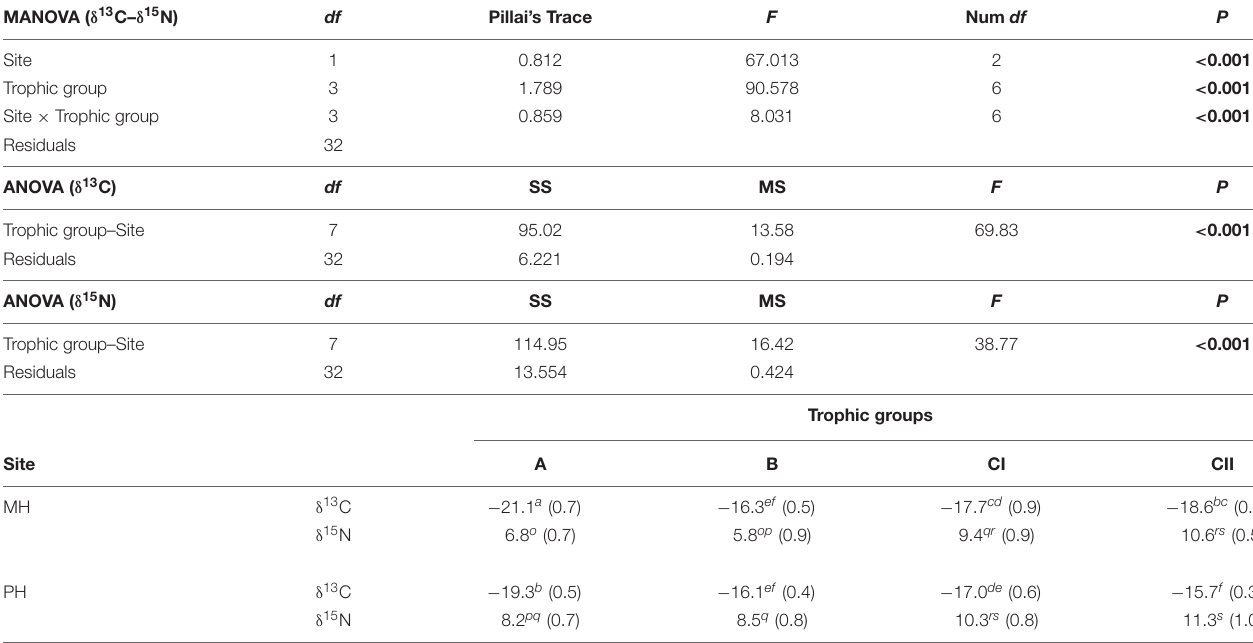
TABLE 5 | MANOVA and ANOVA results, testing differences in the δ 13 C and δ 15 N among trophic groups at two marine ranching sites in the shallow subtidal zone of the east coast of